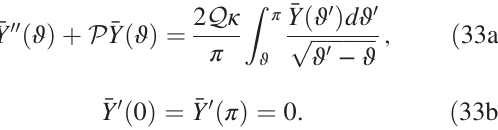
FIG. 8. TMCI threshold of the resistive wall wake. Its asymp- totic value is: q 0 ¼ − 1 . 1 Δ Q .